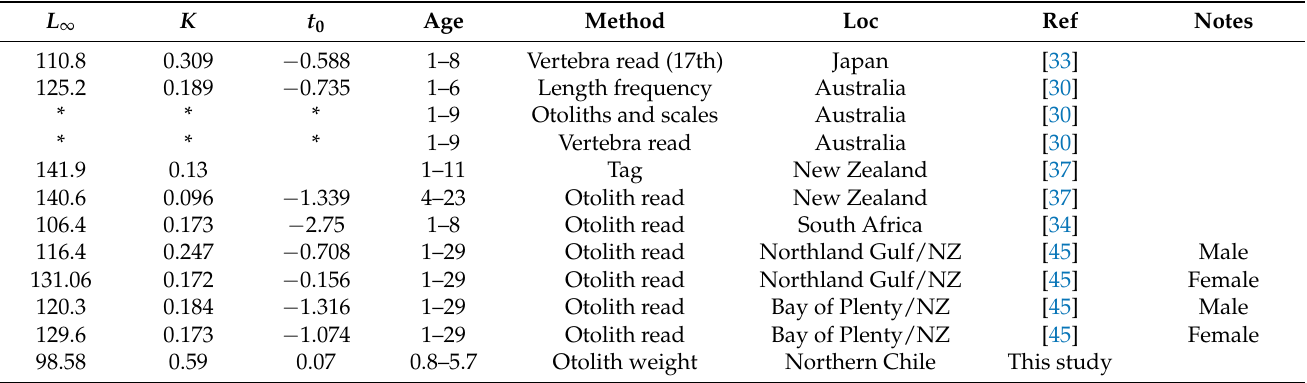
Table 2. Growth parameters for Seriola lalandi from different localities. L ∞ , asymptotic fork length; K , growth coefficient (1/time); t 0 , theoretical age when length is zero. Age = estimated age range; Loc. = locality; Ref =